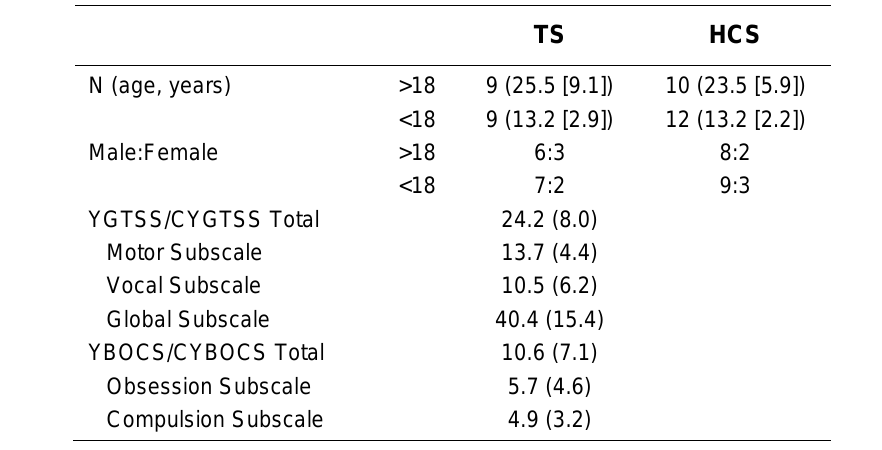
A. Group Characteristics (M